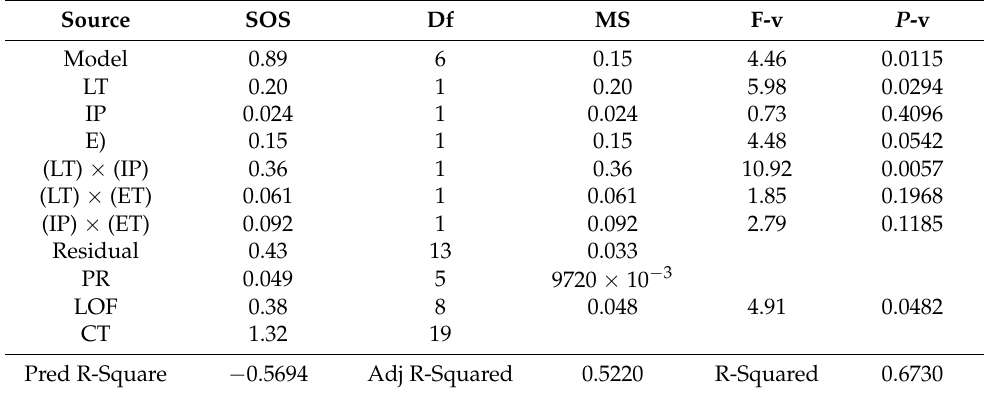
Table 7. ANOVA for